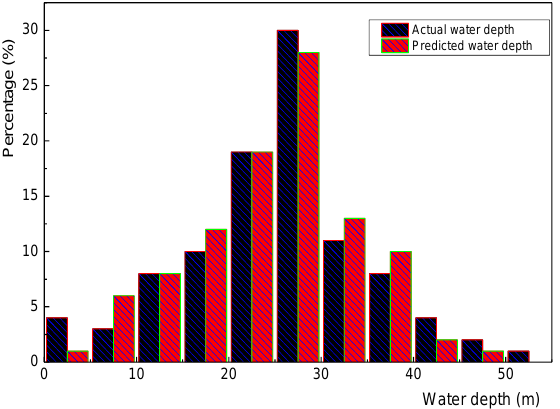
Figure 10. Actual and predicted water depth data from Fangcheng Port.